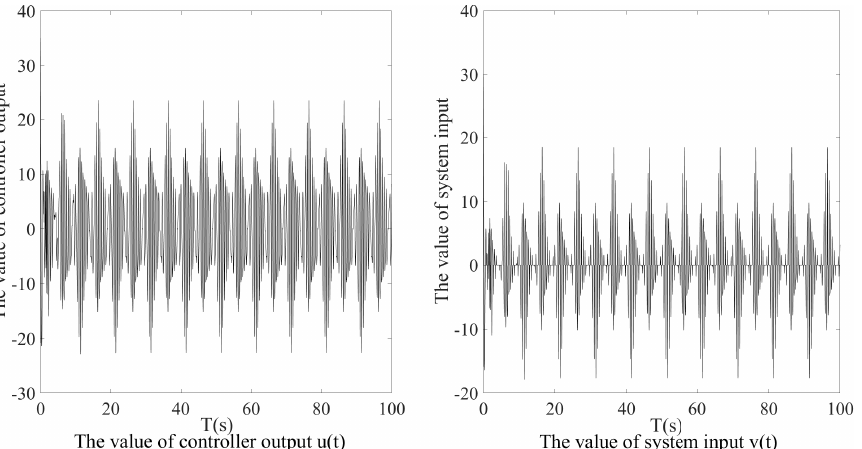
Figure 9. Controller output curve and system input curve in unknown time-varying delay form (with dead-zone compensation controller).